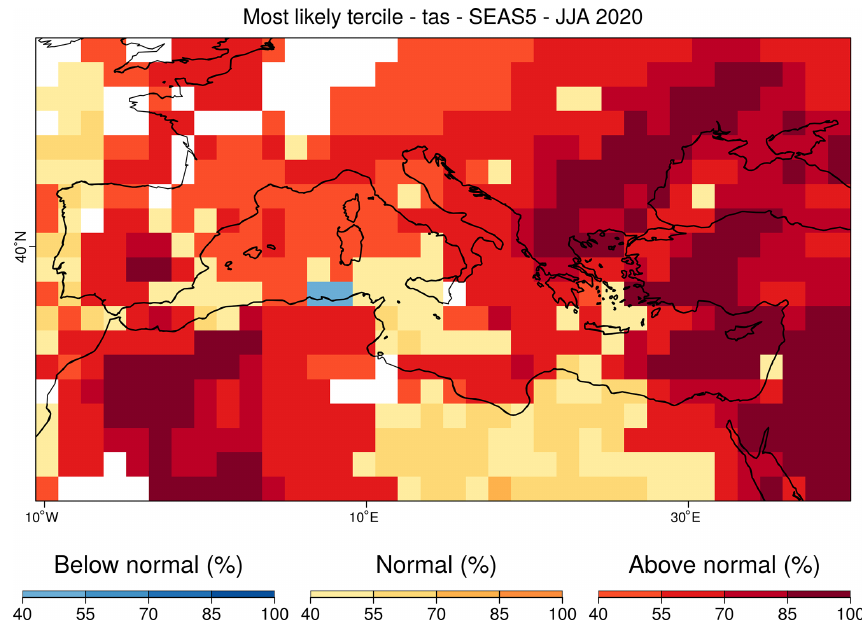
Figure 3. Example of a PlotMostLikelyQuantileMap for which the tercile probabilities of the summer sea surface temperatures of 2020 in the Mediterranean region are compared. The function allows us to apply a mask (white grid points), which in this case correspond to areas where the system does not have sufficient skill for a given metric over the verification